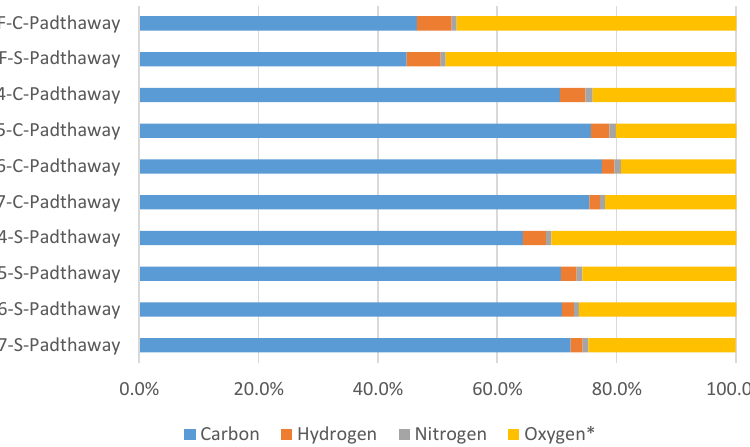
Figure 1. Elemental analysis by CHN. Sample Identification: F = Feedstock sample, C = Grapevine Cane, S = Stalks, 4 = 400 °C Biochar, 5 = 500 °C Biochar, 6 = 600 °C Biochar, 7 = 700 °C Biochar * Oxygen by difference.